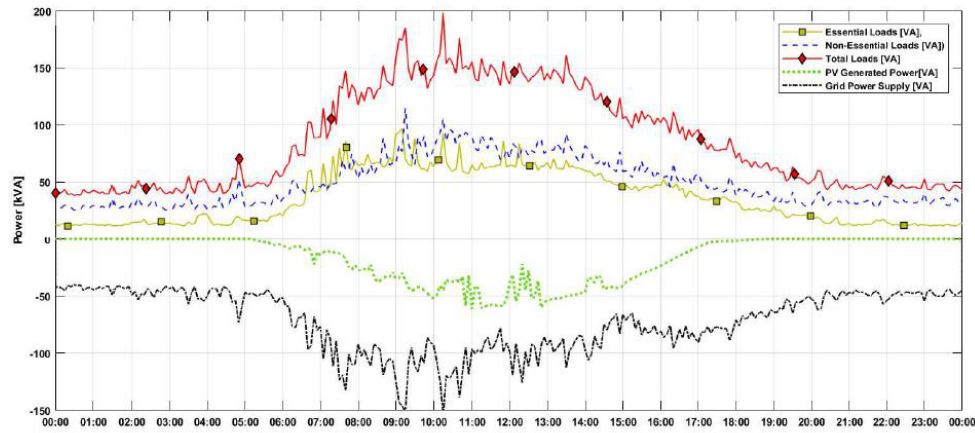
Figure 10. The behavior of MCAST micro-grid without BESS on a typical weekday.